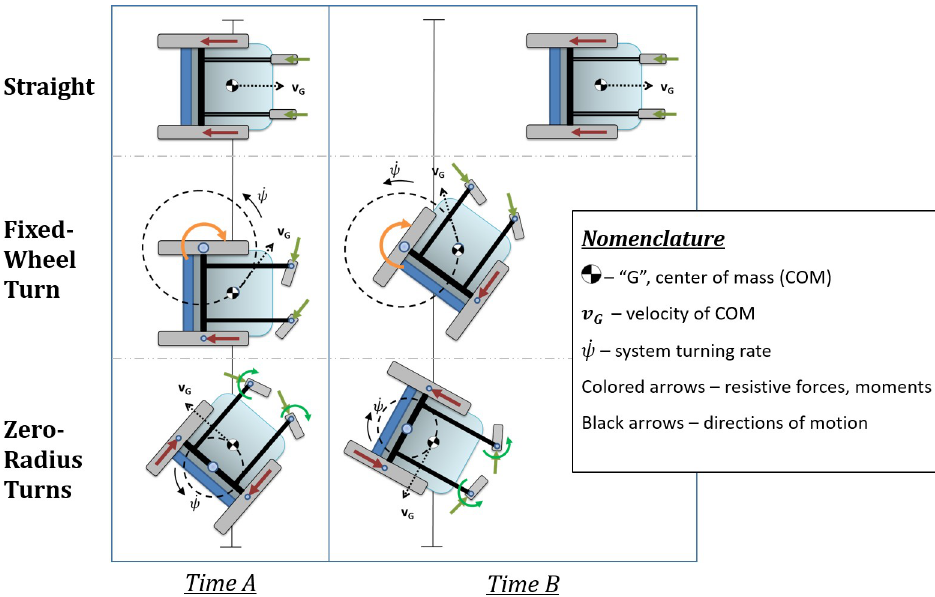
Fig 1. Canonical maneuvers. Graphical depictions of the ‘canonical maneuvers’ used to embody the most common features of MWC motion.